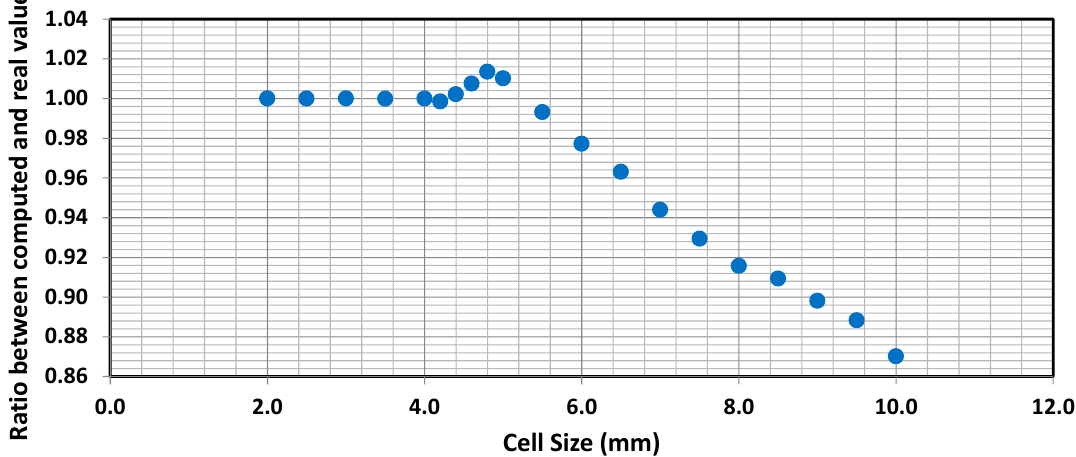
7 of 16 Figure 4. Geometry and meshing structure of a commercial air valve for ANSYS Fluent analysis. The second step is mesh generation, which consists in dividing the domain of the fluid into a number of smaller cells. The solver used (ANSYS Fluent) is based on the finite volume method, where the domain is divided into a finite set of control volumes. The general conservation equations for mass and momentum are solved on this set of control volumes. For the representation of the behaviour of the air valves, a structured tetrahedral mesh has been selected, since this type of mesh allows a better adjustment than the hexahedral meshes, especially in the curved areas of the interior of the valve. In order to ensure proper convergence of the model, a preliminary analysis of the minimum mesh size required was performed. This analysis is performed considering the following boundary conditions: the mass flow rate of air is fixed in the inlet while the pressure remains constant in the output. Specifically in this study the required pressure at the inlet of the valve to generate a flow of 2000 m 3 /h of air under standard conditions, i.e., a mass flow of 0.667 kg/s, has been calculated. All the simulations have been carried out by means of an implicit formulation in steady state. The resolution algorithm uses a density-based method, which has a coupled formulation of the equations of continuity, momentum and energy. This method of resolution allows better representation of the flow than pressure-based algorithms since the latter erroneously characterize negative pressure gradients. The numerical results of the convergence analysis of the mesh are collected in Table 1, where the value of the pressure P required at the inlet of the suction cup is shown based on the reference size used in the mesh and the number of elements it contains. As can be seen in Figure 5, mesh sizes around 4 mm are enough to analyze this type of problem with an adequate level of accuracy. Consequently, considering at least 300,000 cells guarantees an analysis with sufficient precision, as can be seen in Figure 6. Table 1. Results of the mesh convergence analysis. Size (mm)